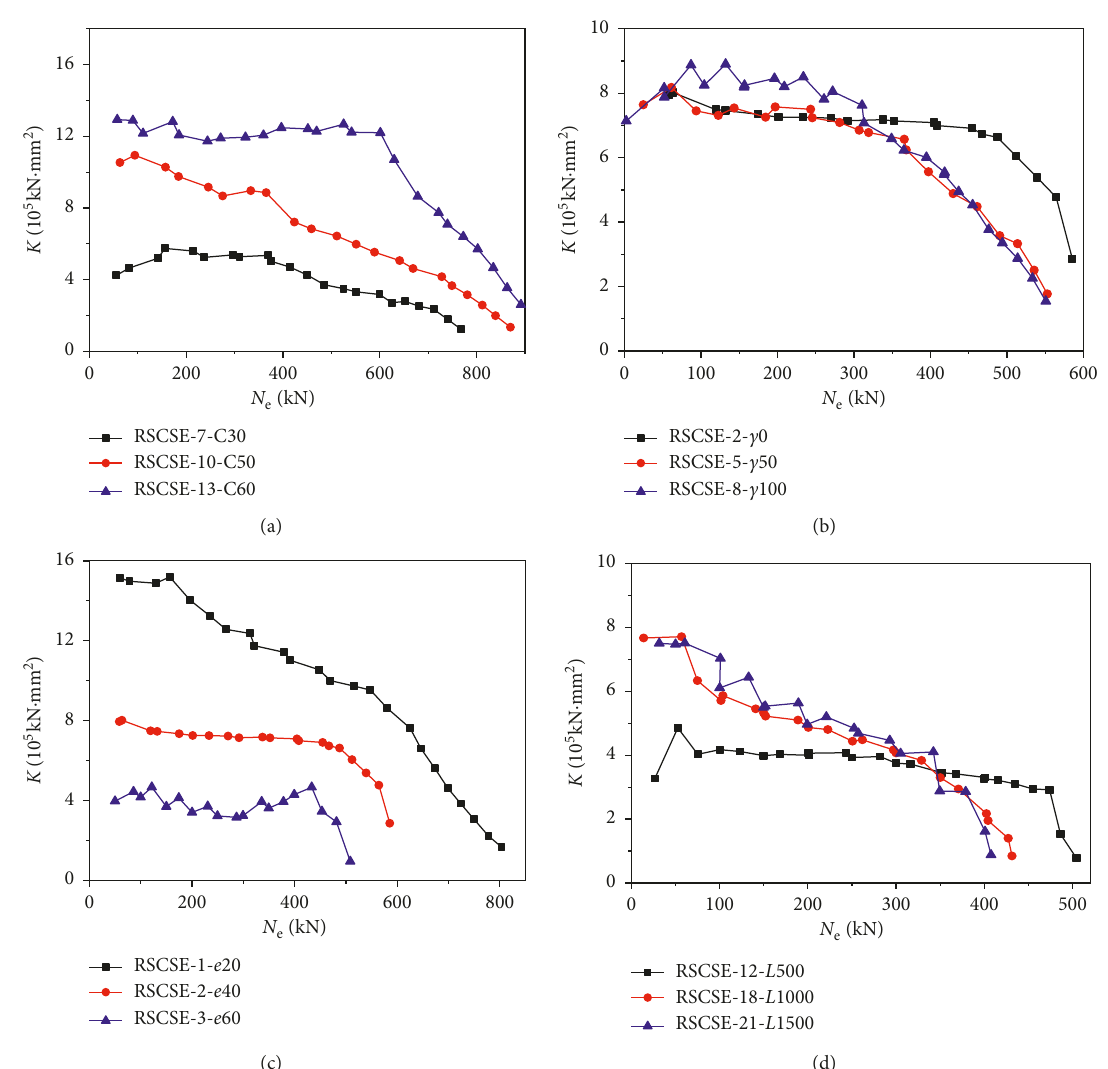
Figure 4: Load-stiffness curves: (a) effect of strength grade of concrete ( e (c) effect of eccentricity (C30- c 0-L500); (d) effect of length-diameter ratio ( e